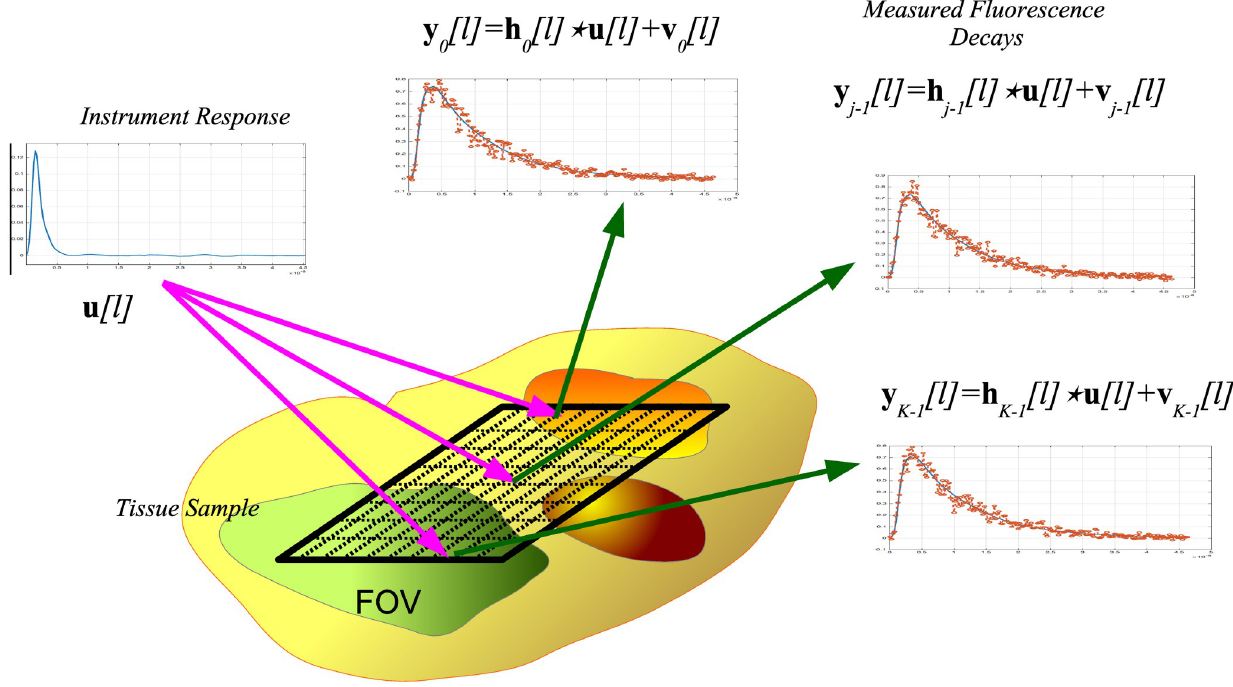
Fig 1. FLIM observation model. The instrument response u [ l ] is common to all K spatial points, and the FluoDs f y between the FluoIRs f h